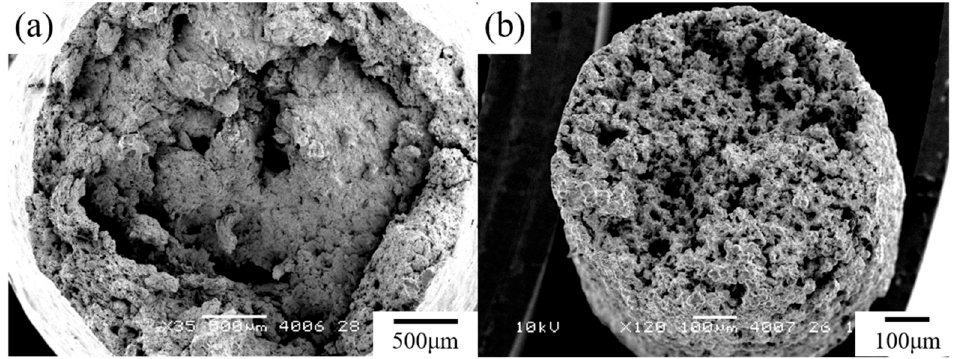
Figure 9. Fractured surface of the Sn-40Bi-1.0Sb alloy after the tensile test under a strain rate of 5.25 × 10 − 4 s − 1 at ( a ) 298 K and ( b ) 353 K.